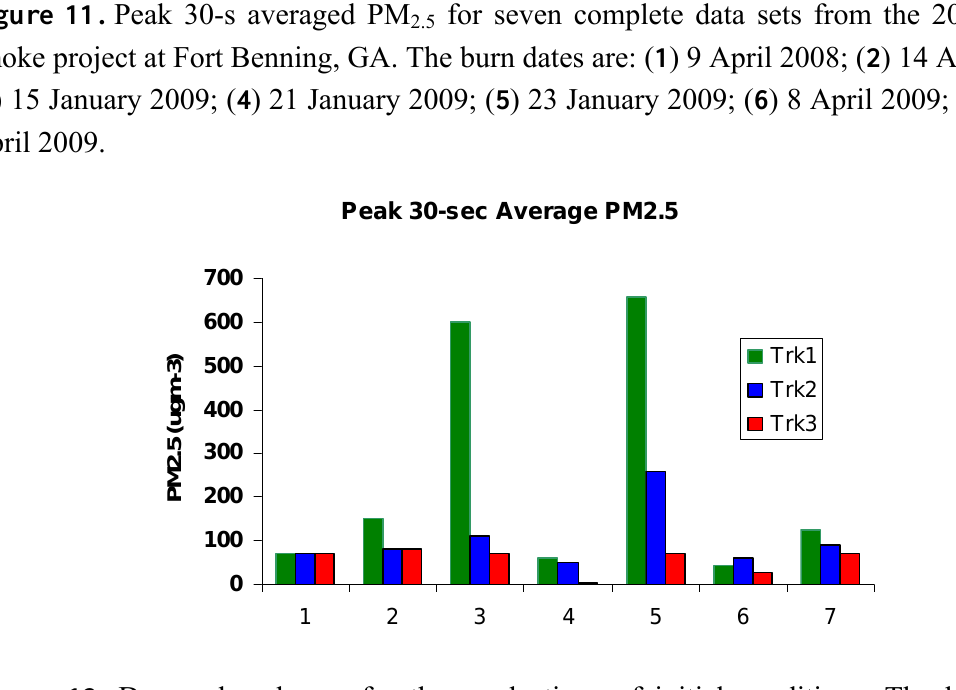
Figure 12. Daysmoke plumes for three selections of initial conditions. The horizontal white line gives the mixing